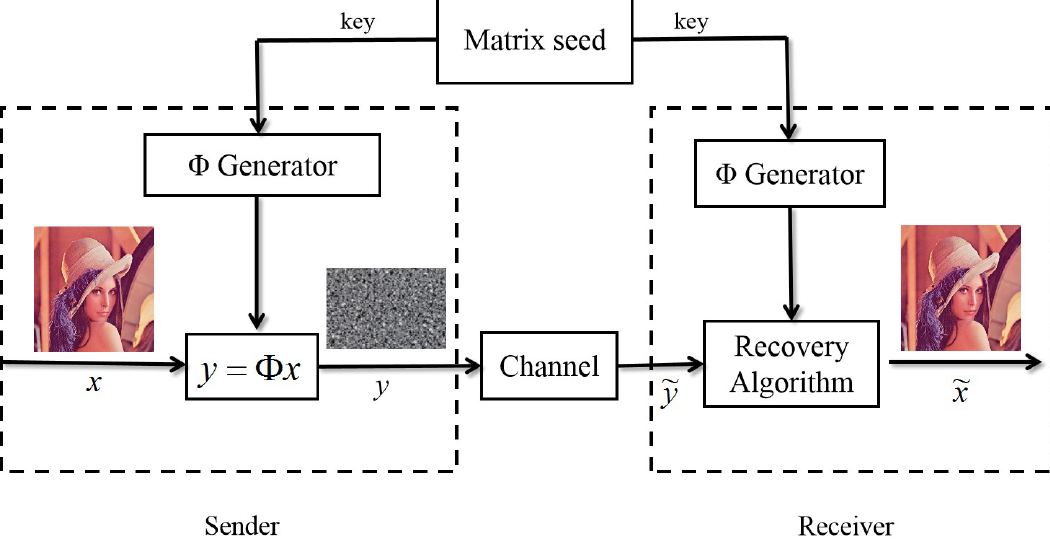
Figure 4. Data-encryption transmission system based on compressed sensing, which can simultaneously realize data encryption and